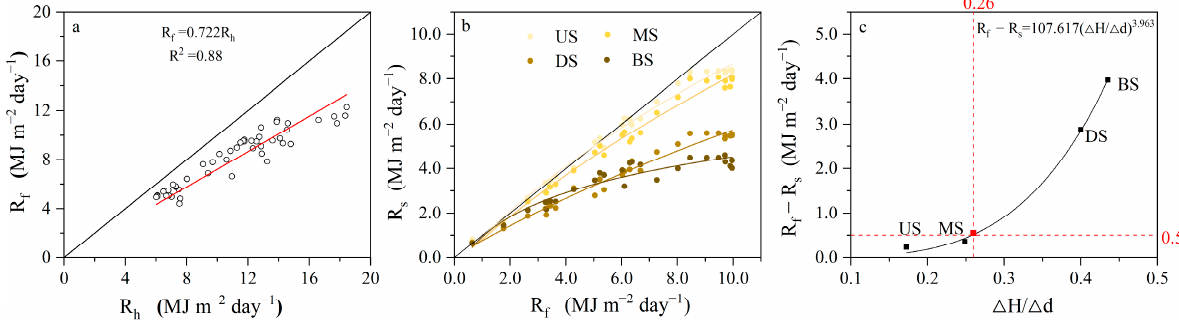
Figure 4. Effect of topographic change on solar radiation income on the hillslope. ( a ) The relationship between R f and R h . R h represents the daily solar radiation income of the horizontal ground; R f represents the daily solar radiation income of the single hillslope. ( b ) The relationship between R s and R f in different slope positions. R s represents the daily solar radiation income outside the forest on the sample slope. The solid black line in ( b ) represents R f = R i . ( c ) The relationship between slope position and shade terrain effect. ( R f — R s ) represents the shaded terrain effect of the opposite mountain; ∆ H / ∆ d represents the ratio of the height difference to the horizontal distance between the sample point and the top of the opposite mountain (i.e., the variation of the slope position), the ∆ H value represents the elevation difference between the sample point and the opposite mountain top; the ∆ d value represents the horizontal distance between the sample point and the opposite mountain top; upper slope ( US ), middle slope ( MS ), down slope ( DS ) and bottom slope ( BS ). The ( ∆ H / ∆ d < 0.26) was the threshold indicating that the sample point has no shaded terrain effect, that is, R f — R s < 0.5 MJ m − 2 day − 1